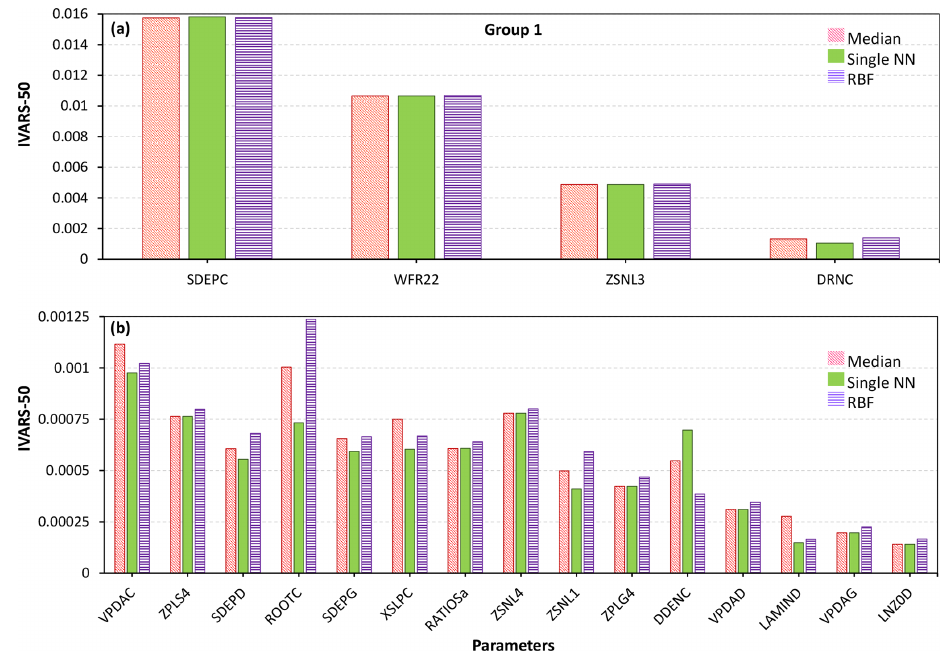
Figure 11. Sensitivity analysis results of the MESH model using different crash-handling strategies for the most influential parameters. To better illustrate the results, the highly influential parameters in Group 1 (see Fig. 10) are separately shown in panels (a) and (b)